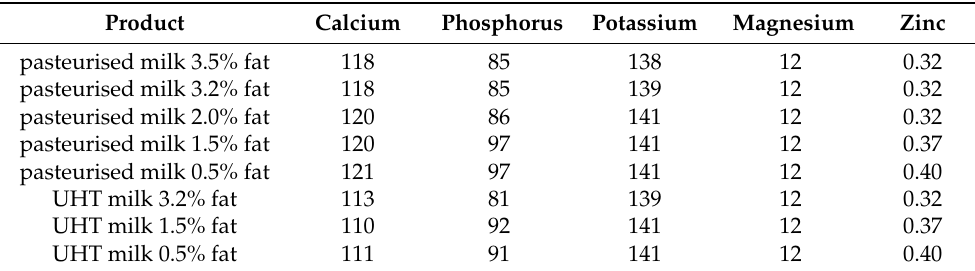
Table 2. Content of selected minerals in mg/100 g of drinking milk. Adapted from